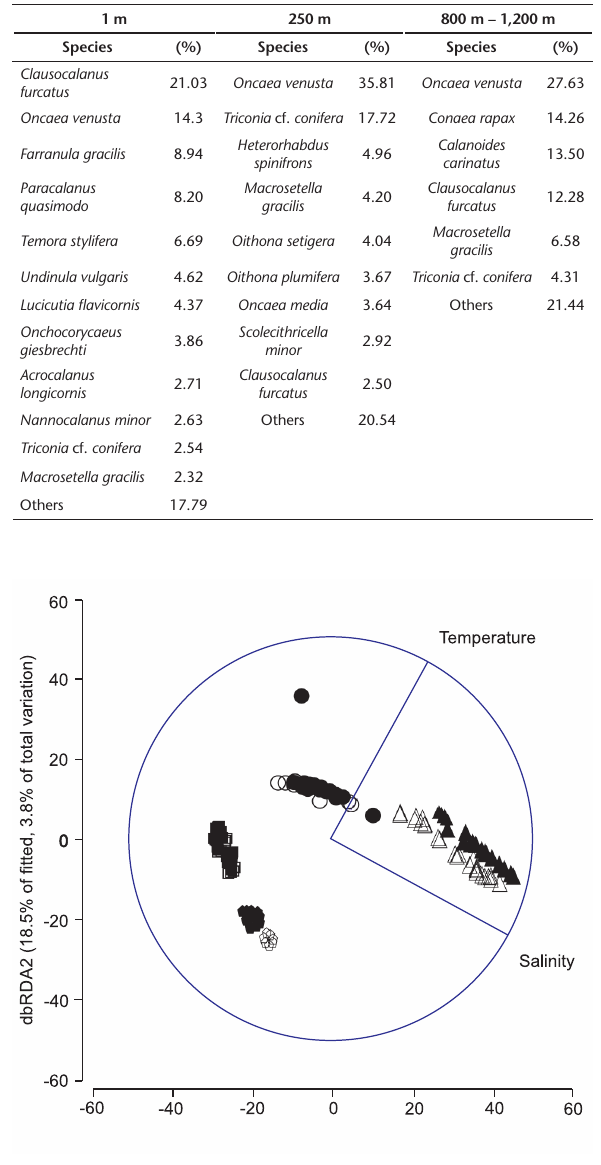
Figure 5. DbRDA ordination derived from DistLM analysis, including the main environmental parameters explaining the variability in copepod assemblage structures during the sampling period. Temp, temperature; Sal, salinity. Black triangle, rainy season 1 m;